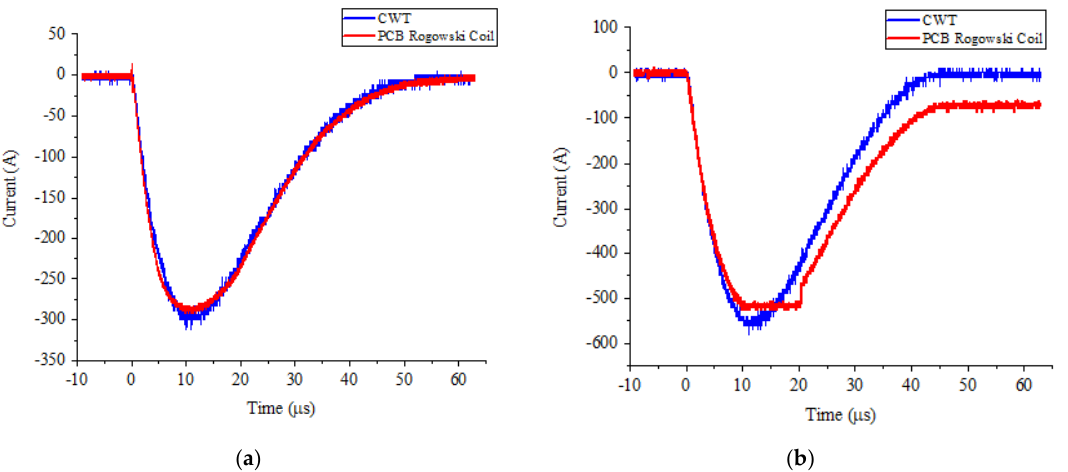
Figure 14. Experimental results of lightning surge signal (negative polarity). ( a ) The measured current peak value is 300 A. ( b ) The measured current peak value is 550 A.